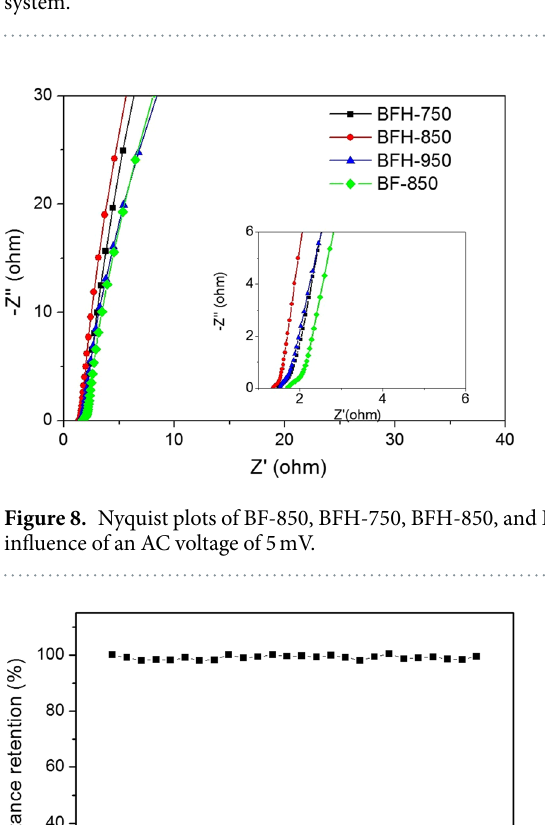
Table 2. Comparison of electrochemical performance of biomass-derived carbon materials in a three-electrode system.